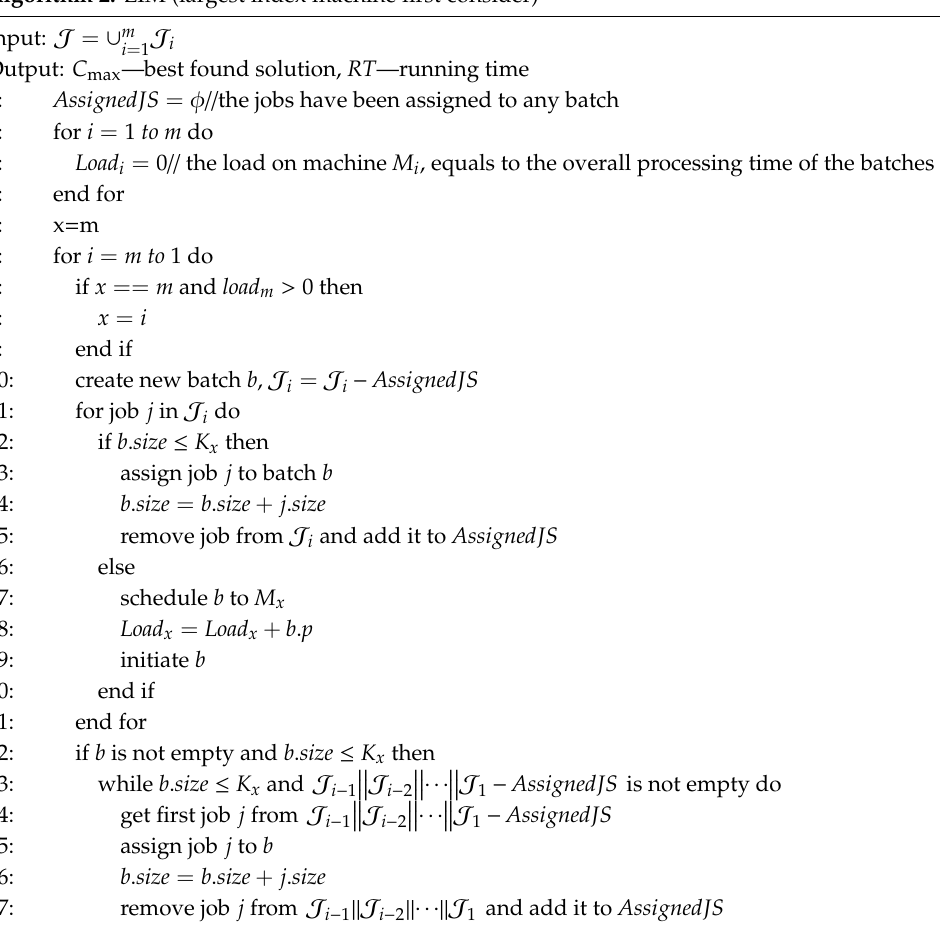
Algorithm 2. LIM (largest index machine first